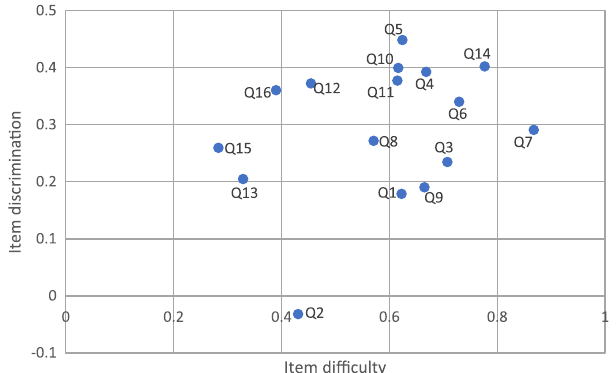
FIG. 5. Item statistics for all original 16 items of the ROC-CI. Item Q2 shows negative